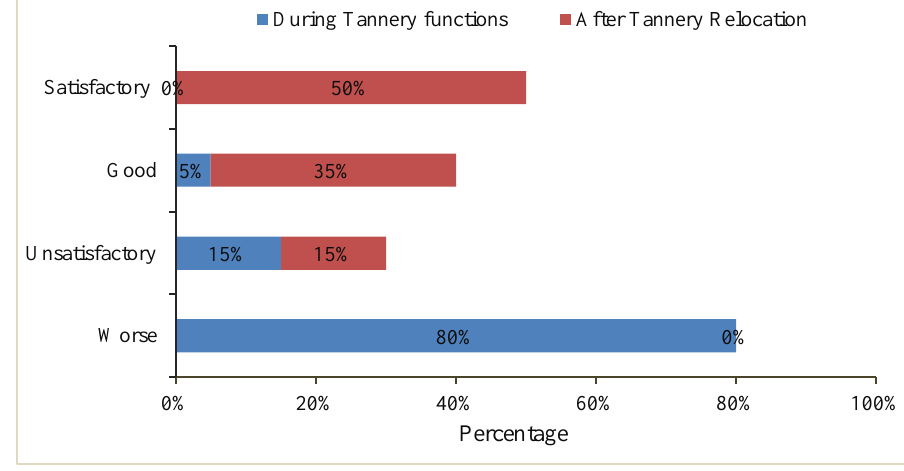
Figure 4: Change of Odor Condition in